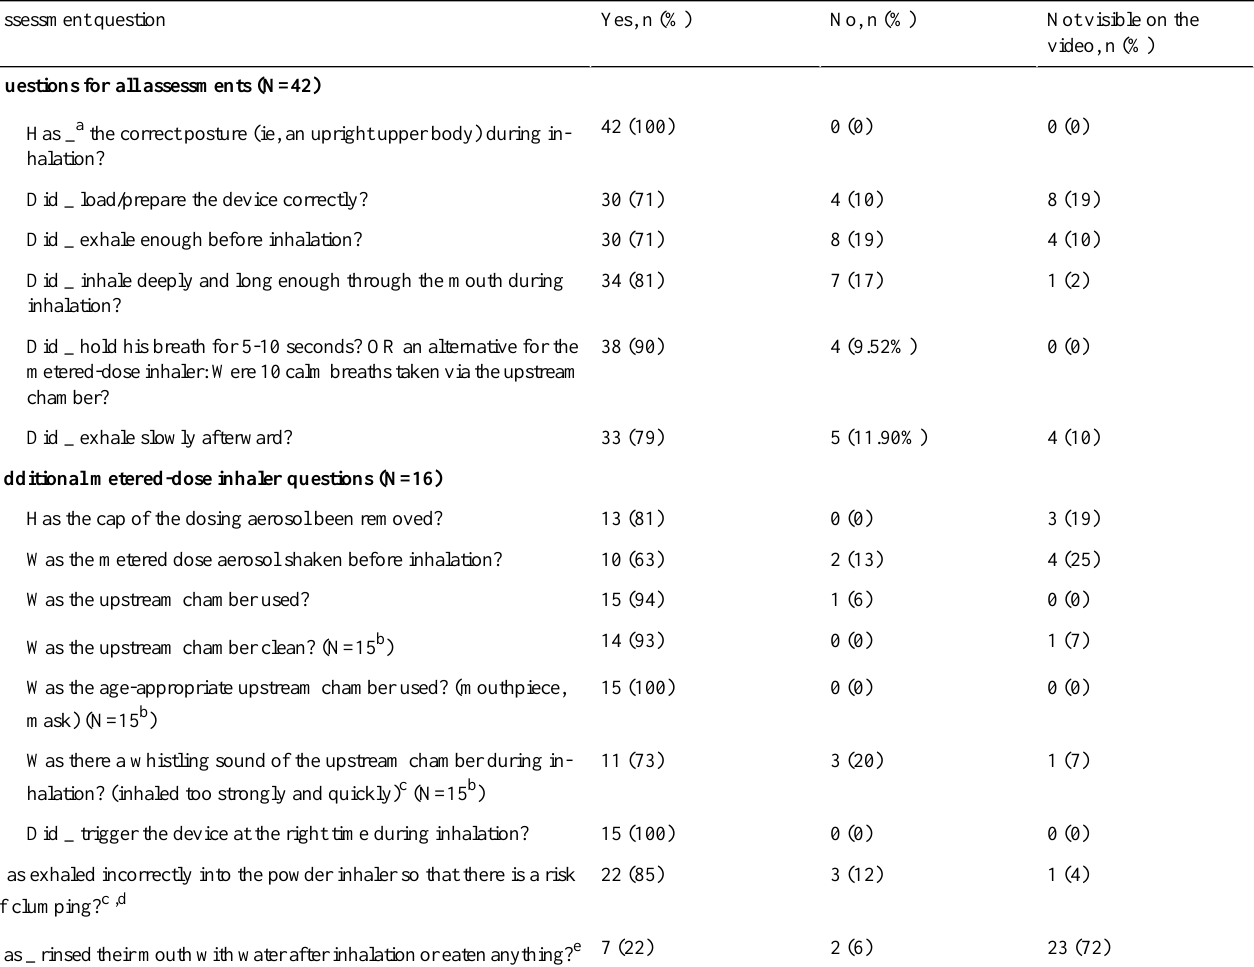
Table 3. Inhalation technique assessments by health care professionals.